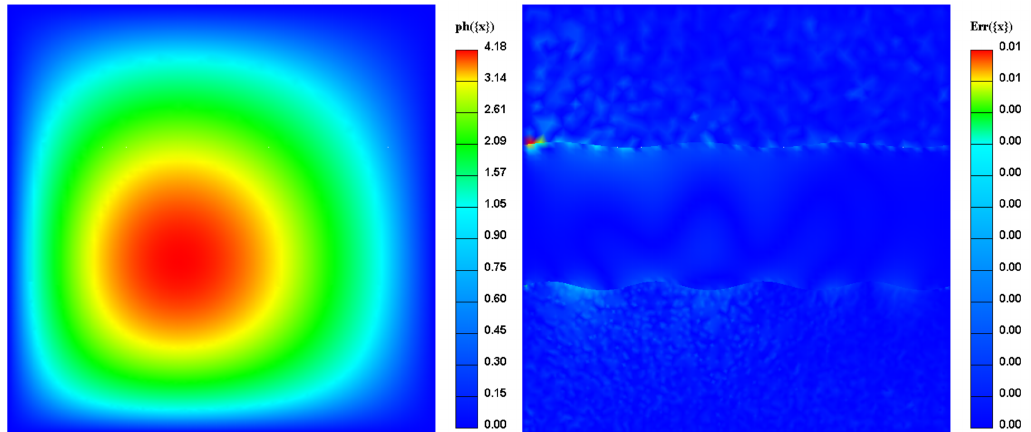
Figure 12. Partitioning for DN ( left ) and MFEM ( right ) problems. Figure 12: Partitioning for DN and MFEM problems